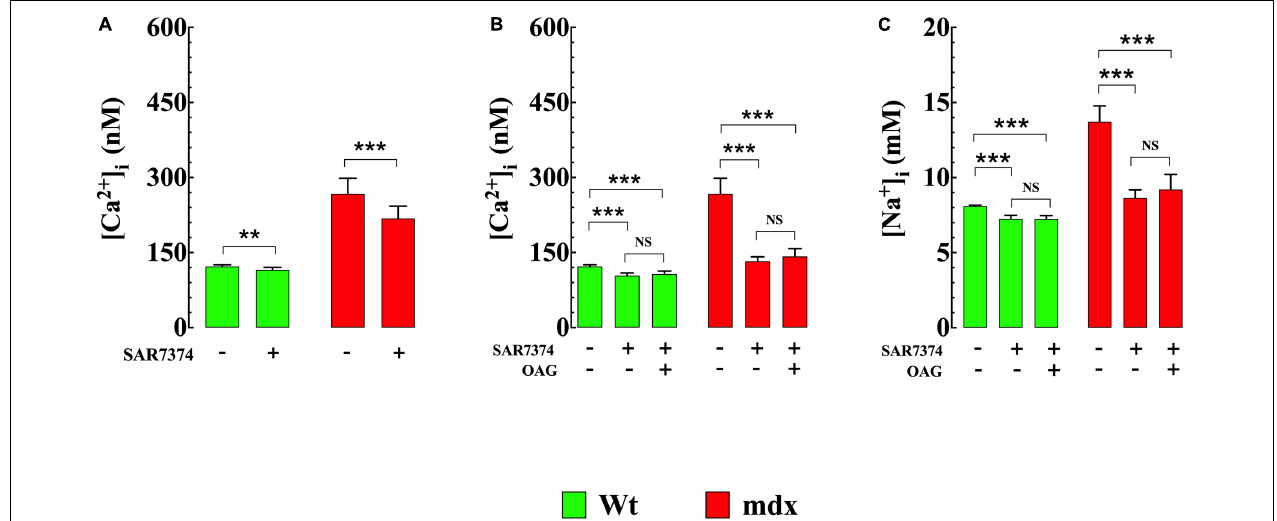
FIGURE 5 | SAR7334 reduced [Ca 2 + ] i and [Na + ] i and blocked the elevation of [Ca 2 + ] i and [Na + ] i induced by OAG. [Ca 2 + ] i was measured in VSMc isolated from Wt and mdx mice before and after incubation in SAR7374 (0.1 µ M or 1 µ M), as well as after the exposure with SAR7374 and OAG (100 µ M). (A) shows that preincubation in SAR7374 (0.1 µ M) reduced significantly [Ca 2 + ] i and [Na + ] i in both genotypes. (B) illustrates that SAR7374 (1 µ M) further reduced [Ca 2 + ] i and [Na + ] i and prevented the increase in intracellular [Ca 2 + ] and [Na + ] induced by OAG. (C) shows that SAR7374 (1 µ M) reduced [Na + ] i in control and mdx VSMc and prevents the elevation of [Na + ] i induced by OAG. Over the horizontal axis are indicated the experimental conditions used to measure [Ca 2 + ] i and [Na + ] i . For [Ca 2 + ] i : n mice = 3/experimental condition, n cell = 17–20/genotype. For [Na + ] i : n mice = 3/experimental condition, n cell = 13–19/genotype. Values are expressed as means ± S.D. for each condition. One-way ANOVA with Tukey’s post-test, ** p < 0.01, *** p ≤ 0.001.